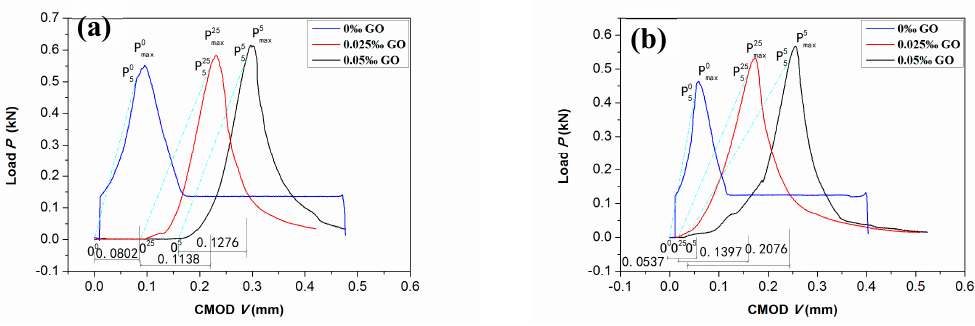
Figure 5. The P - CMOD curves of ( a ) GONM; ( b ) GORM.